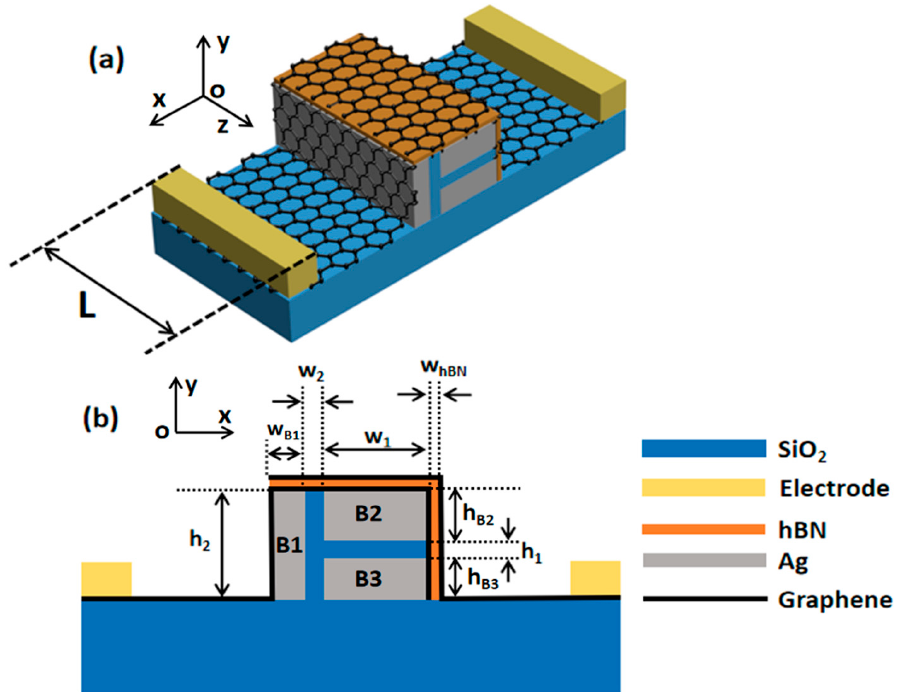
Figure 1. ( a ) Three-dimensional schematic diagram of graphene modulator based on metal slot waveguide; ( b ) Two-dimensional cross-sectional view of graphene modulator.